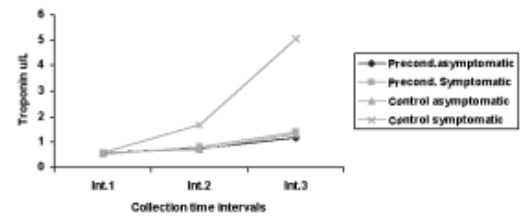
Fig. 4 - Evolution of Troponin I at different time intervals of collection for the groups Int. 1 – Initiation of cardiopulmonary bypass Int. 2 – After the first